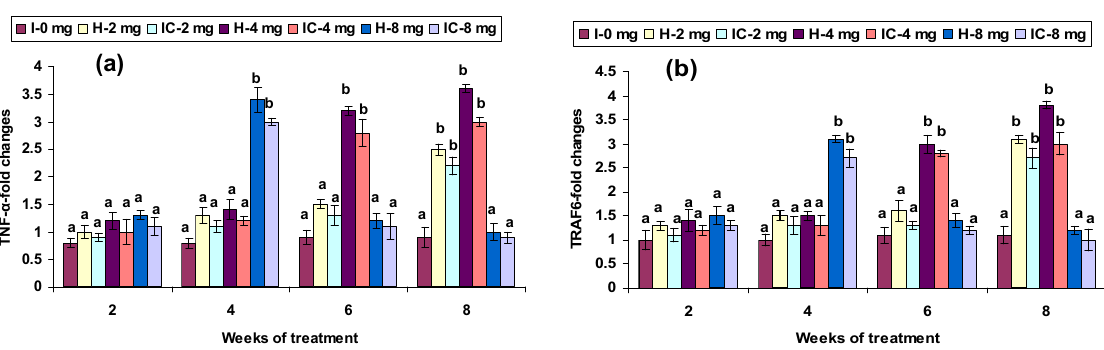
Figure 8. Expression pattern of ( a ) IFN-γ, ( b ) MHC-I, ( c ) MyD88, and ( d ) NF-kB relative to β-actin in the head kidney of catla (n = 3) against A. hydrophila . H healthy, I infected. Values are expressed as mean ± SD and the statistical difference between means ( P < 0.05) indicated in different letters in each column.